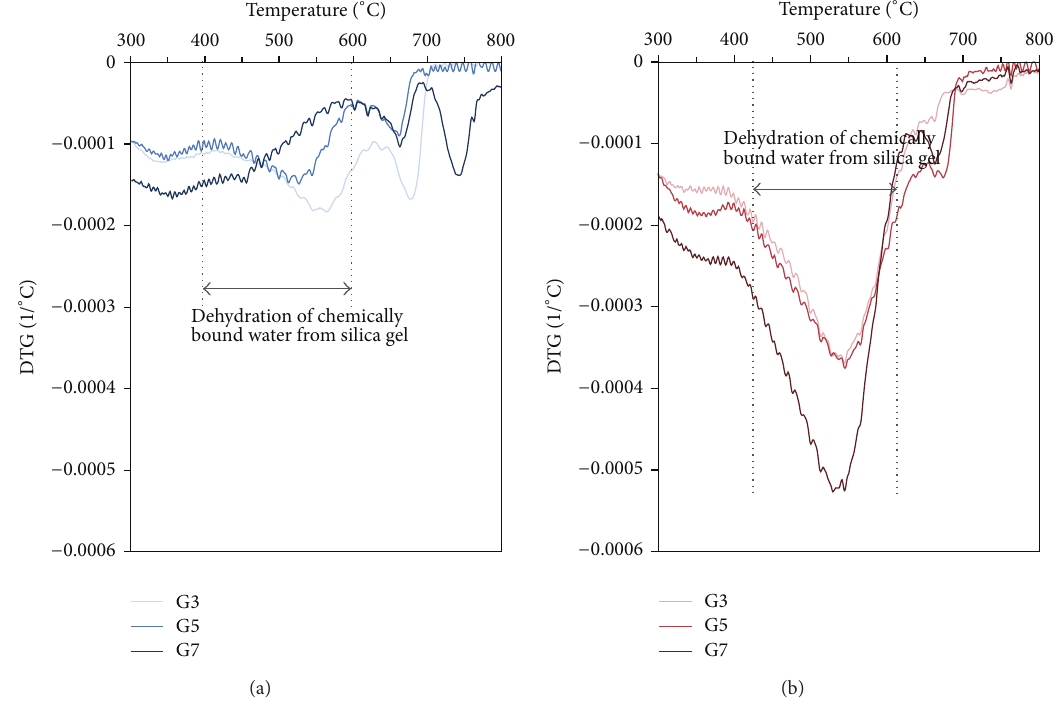
Figure 12: Differential thermograms (mass loss downwards) of noncarbonated (a) and carbonated (b) AAS mortar with different Na 2 O/S . M ratios.